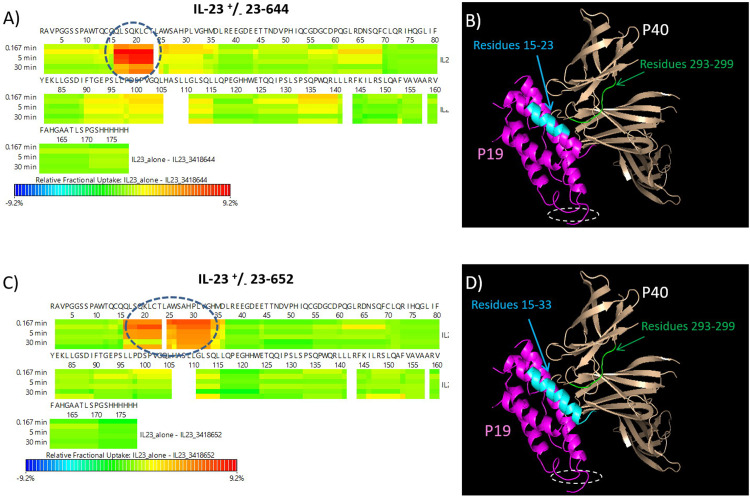
Deuterium uptake plots of IL-23 in the presence and absence of peptides determined by HDX MS.A) Regions on IL-23 with differences in deuterium uptake is shown for A) 23–644 and C) 23–652. The binding region for 23–644 and 23–652 are linear and includes residue 15 to 23 (QQLSQKLCT) and 15 to 33 (QQLSQKLCTLAWSAHPLVG) on p19, respectively. These regions are indicated in dashed blue circles. No significant deuterium uptake difference was observed in p40 subunit, except for possible binding/blockage or structural changes at residues 293–299. This region is spatially proximal to peptide binding site on p19. Crystal structure 3DUH was used to show a surface view of IL-23 that is involved in peptide binding is shown for B) 23–644 and D) 23–652. IL-23R binding site is shown in white dashed circle.